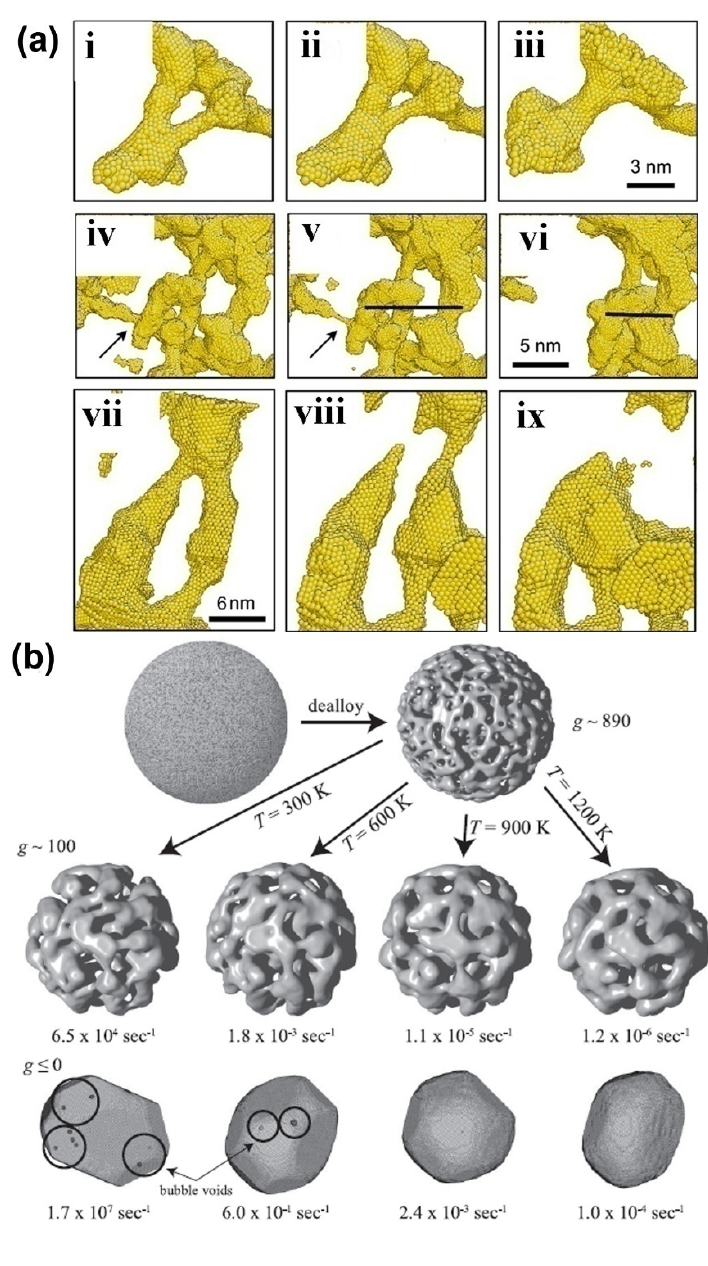
Figure 3. ( a ) Several examples of ligament collapse during annealing at constant volume; in (i–iii) the collapse to two neighboring ligaments, (iv–vi) the pinch-off of the ligament marked by an arrow and (vii–ix) the collapse of two pinched-off ligaments. Reproduced with permission from Reference [73]. (Copyright Elsevier 2011). ( b ) Snapshots of microstructure evolution of NPMs from high topological genus nanoporous nanoparticle to Wulff shape at different temperatures. Reproduced with permission from Reference [74].